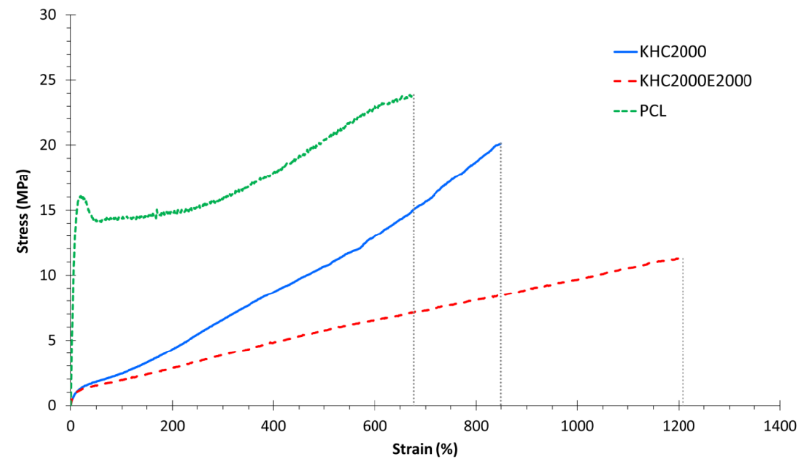
Figure 1. Stress-strain curves of PCL (green, dotted line), KHC2000 (blue, continuous line) and KHC2000E2000 (red, dashed line).